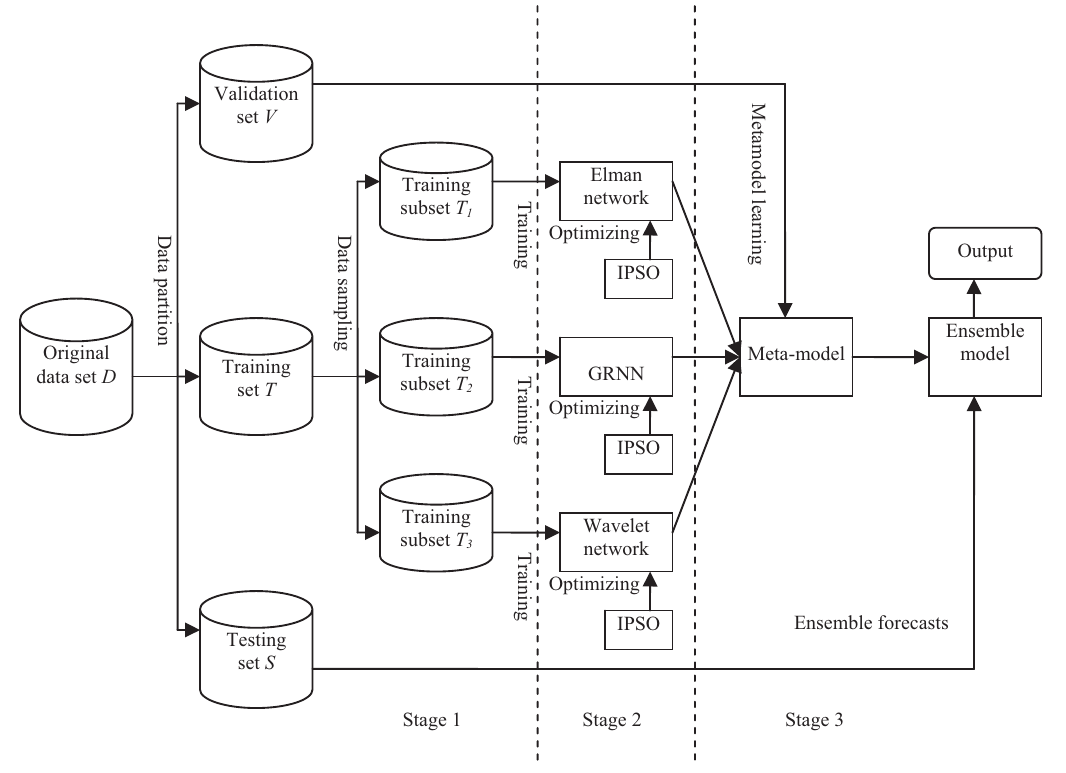
Fig. 1. A flow diagram of the nonlinear ensemble forecast